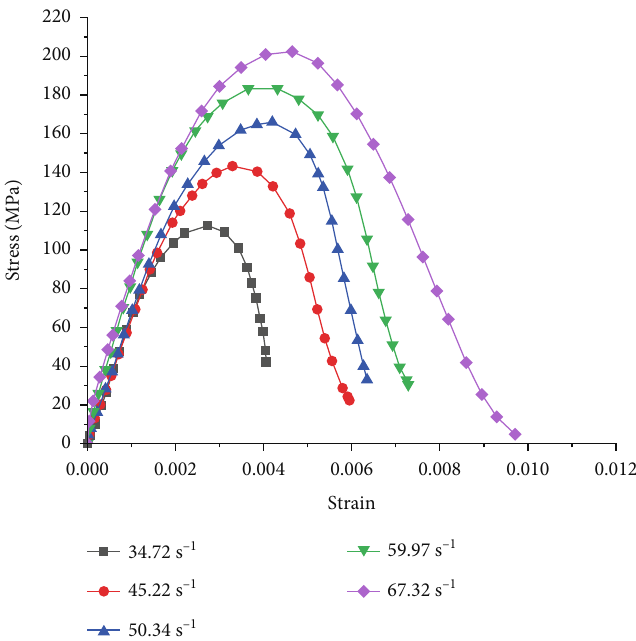
Figure 6: Curves of dynamic stress-strain at di ff erent strain